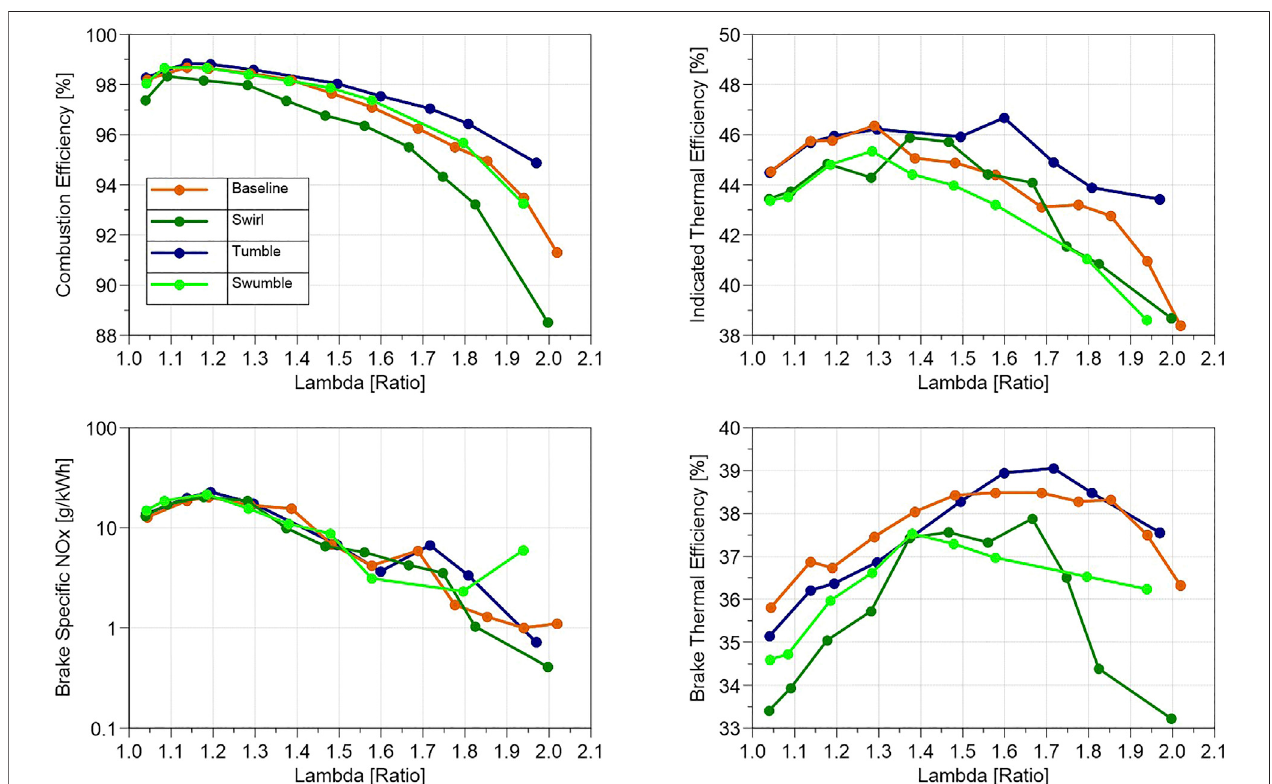
FIGURE 7 | Ef fi ciency and emissions metrics vs. lambda; 1,500 rpm, 6 bar BMEP, CA50 (cid:1) approximately 8 ° after TDC.